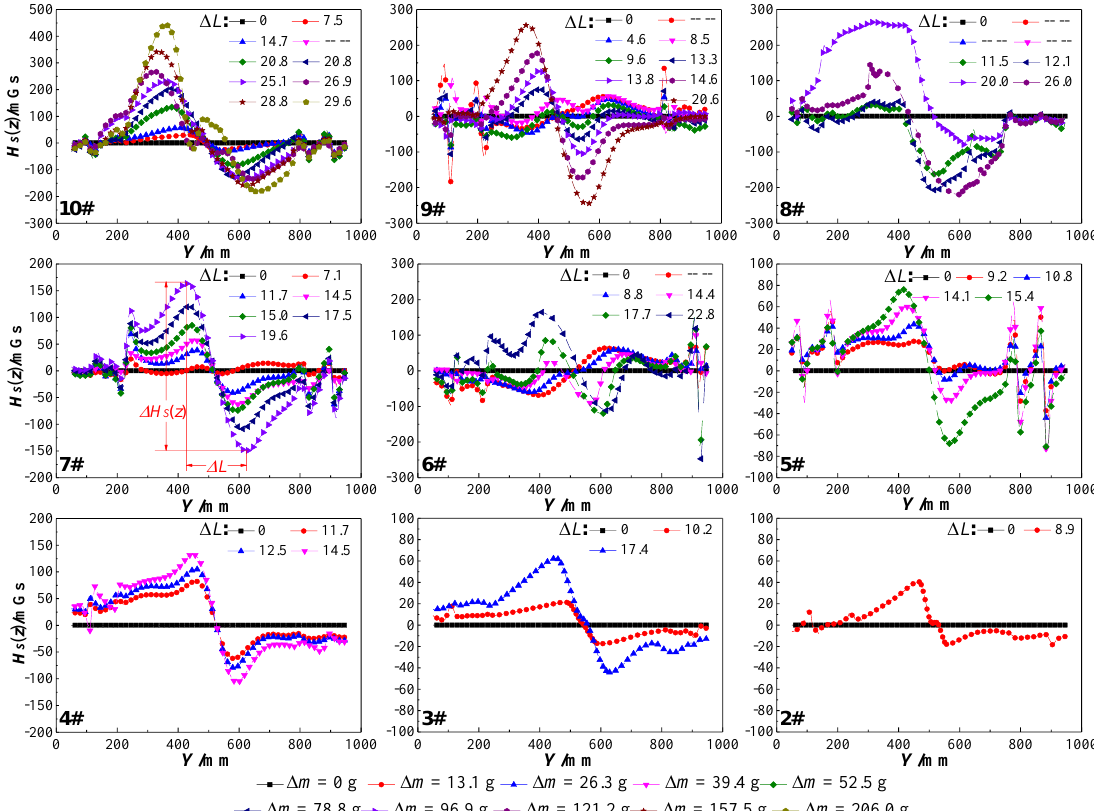
Figure 9. H S ( z ) curves of 2 – 10 tested beam with LFH = 5 mm.